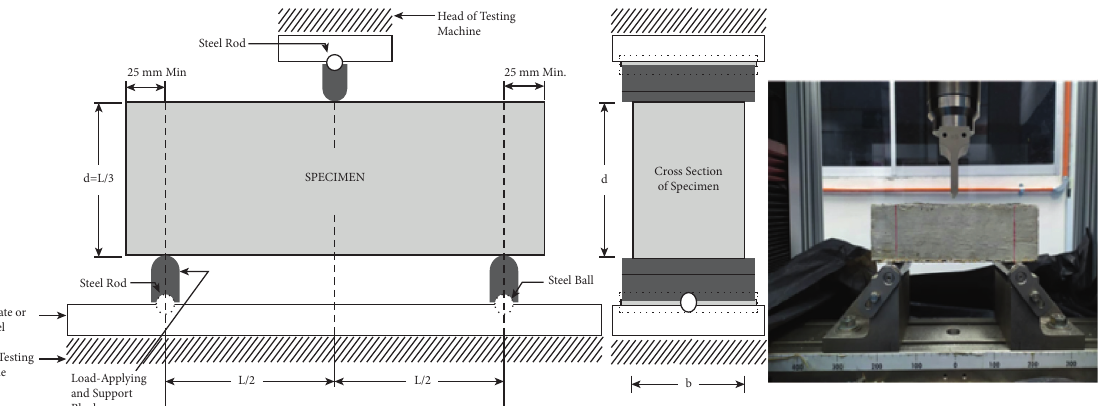
Figure 3: Experiment setup of flexural test.